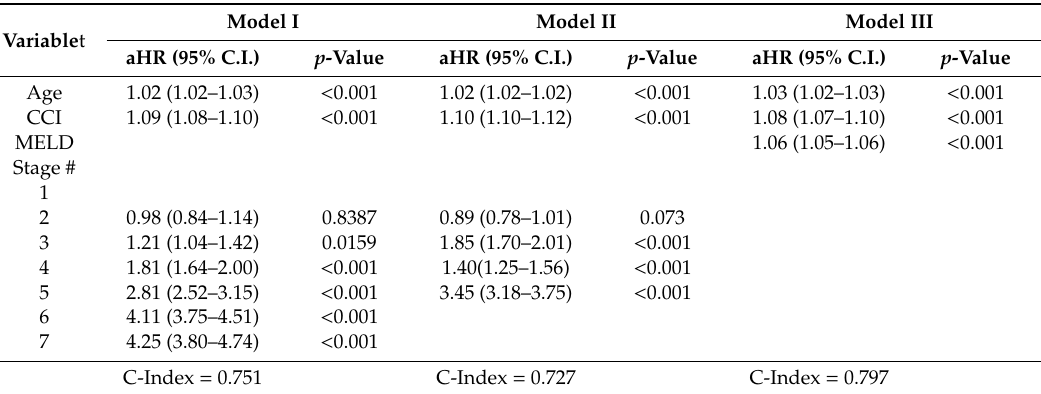
Table 4. Multivariable Cox regression models for overall